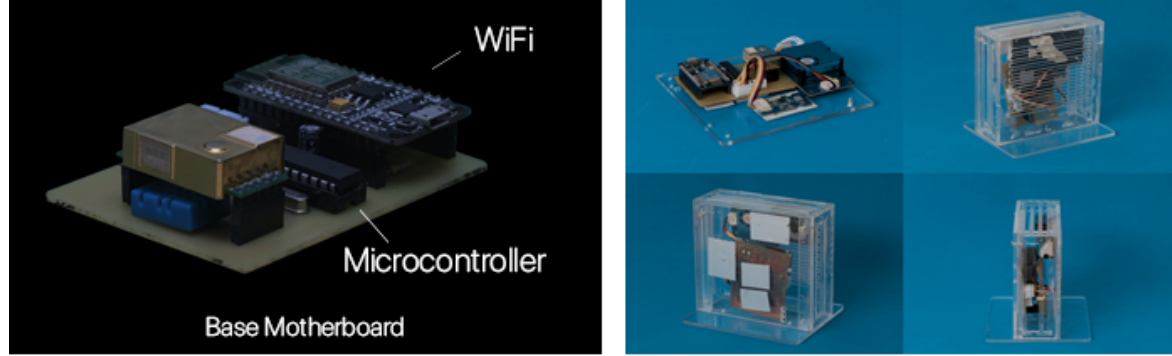
Figure 4. Indoor air quality monitoring